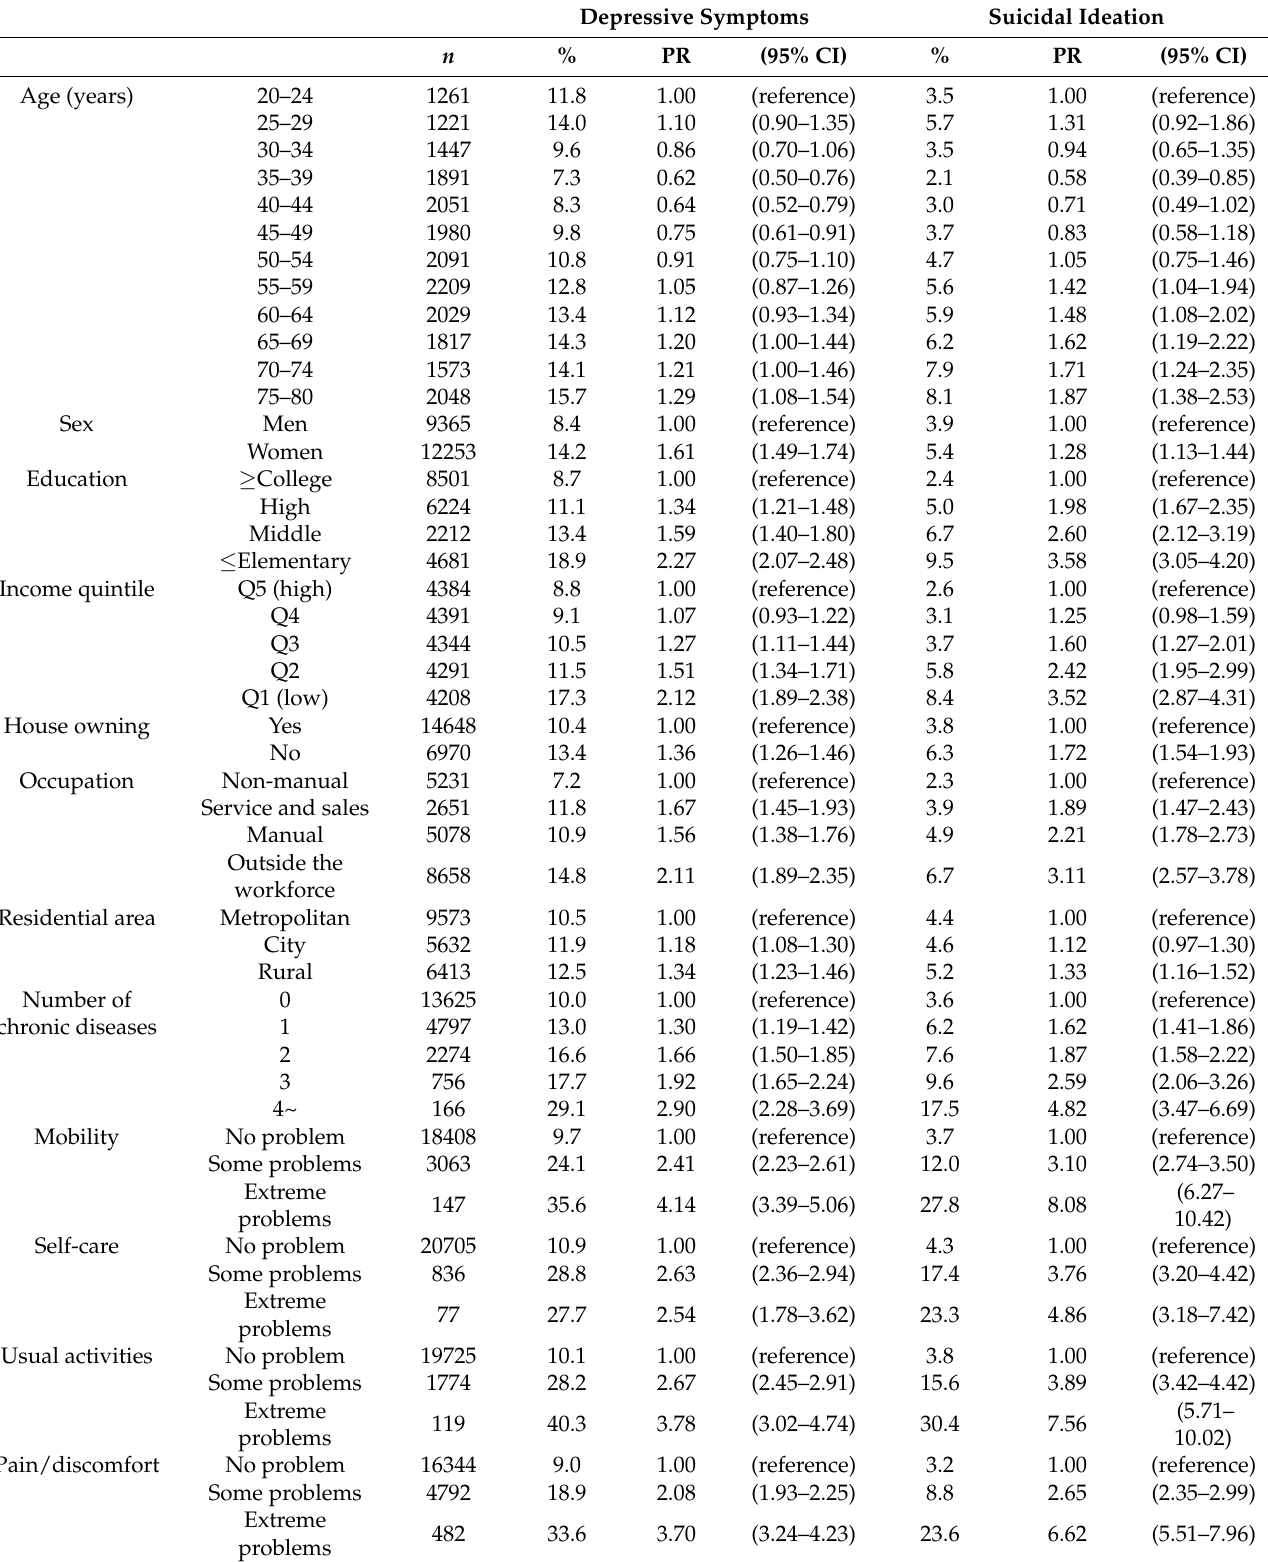
Table 2. Association between sociodemographic factors and depressive symptoms and suicidal